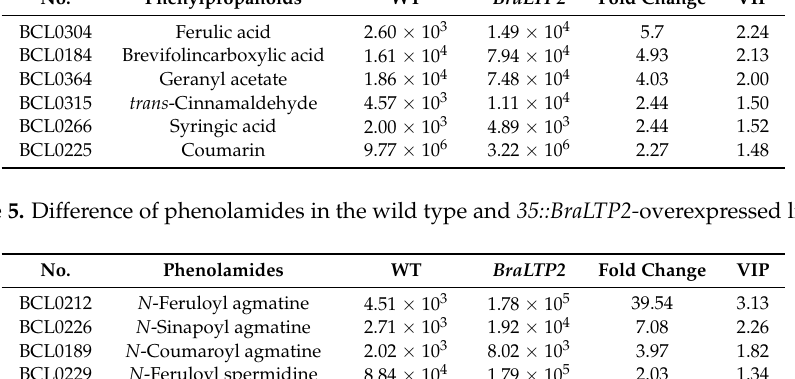
Table 4. Difference of phenylpropanoids in the wild type and 35::BraLTP2 -overexpressed lines. No.